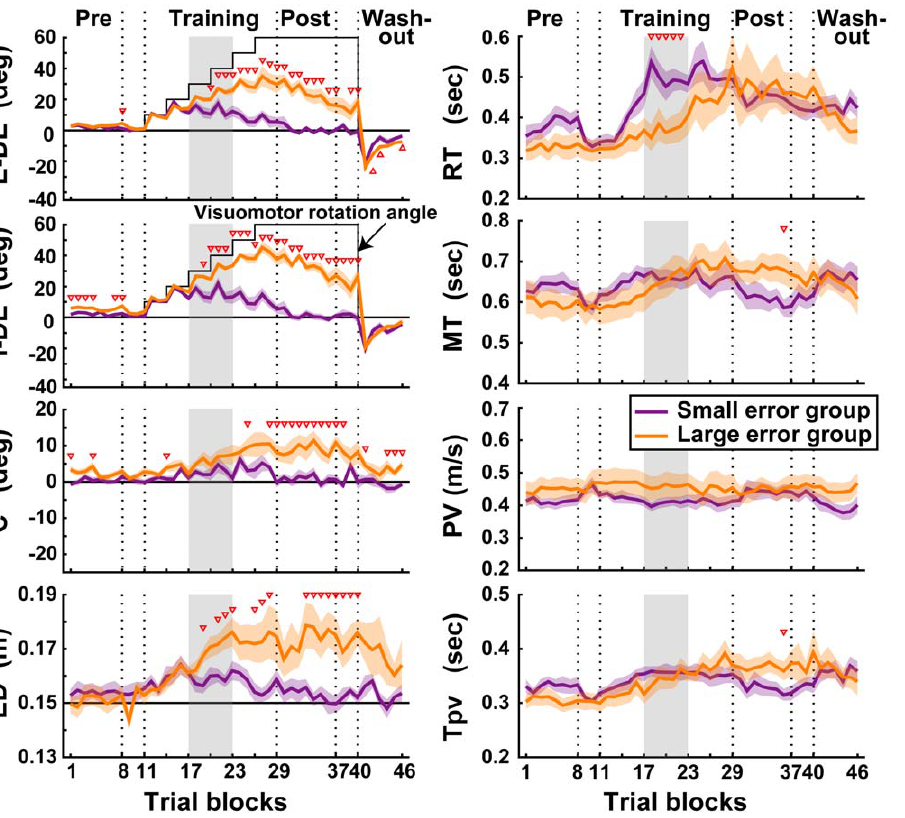
Figure 7. Changes in reaching movement characteristics by the gradual visuomotor rotation learning without online cursor feedback. Thick purple and orange lines in each panel indicate the SEG and LEG, respectively. Gray shaded blocks indicate the middle stage of the training phase (from the 18 th to 22 nd blocks, see Results). The notation is same as in Fig. 2A.